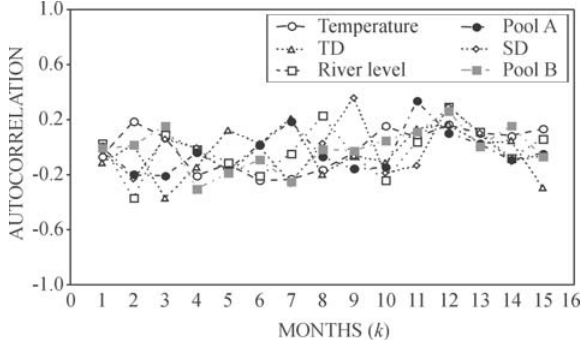
Fig. 5. Correlograms of the residuals of the autoregressive models applied (VV: spillway discharge; VT: turbine discharge) to the data collected in the experimental ladder located near Itaipu Dam.